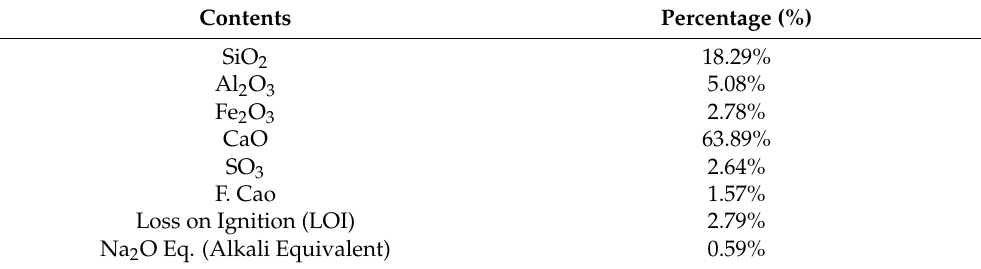
Table 2. CEM I cement chemical composition as provided by Irish